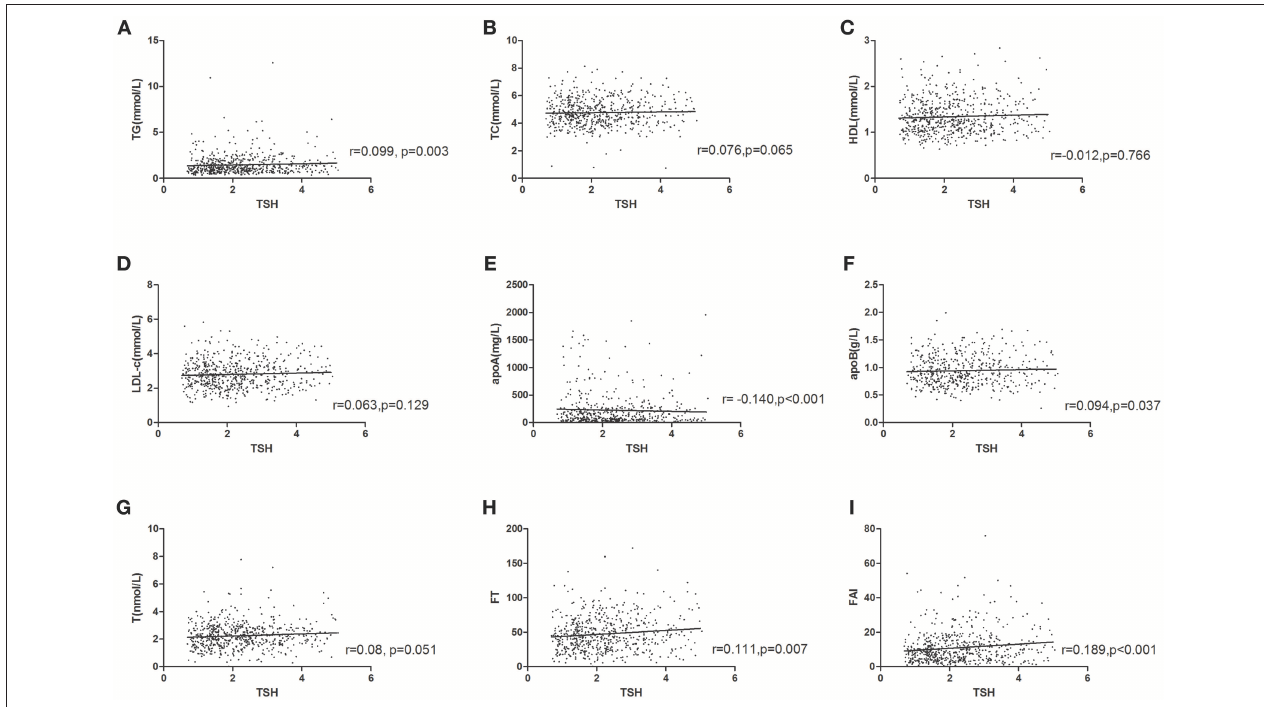
FIGURE 1 | Relationship of TSH level with lipid and androgen parameters in PCOS. (A) TG ( r = 0.099, p = 0.003); (B) TC ( r = 0.076, p = 0.065); (C) HDL-c ( r = − 0.012, P = 0.766); (D) LDL-c ( r = 0.063, p = 0.129); (E) apoA ( r = − 0.140, p < 0.001); (F) apoB ( r = 0.094, p = 0.037); (G) total T ( r = 0.08, P = 0.051); (H) free T ( r = 0.111, p = 0.007); (I) FAI ( r = 0.189, P < 0.001). p -value for Pearson (normal distribution)/Spearman’s (skewed distribution) correlation tests.